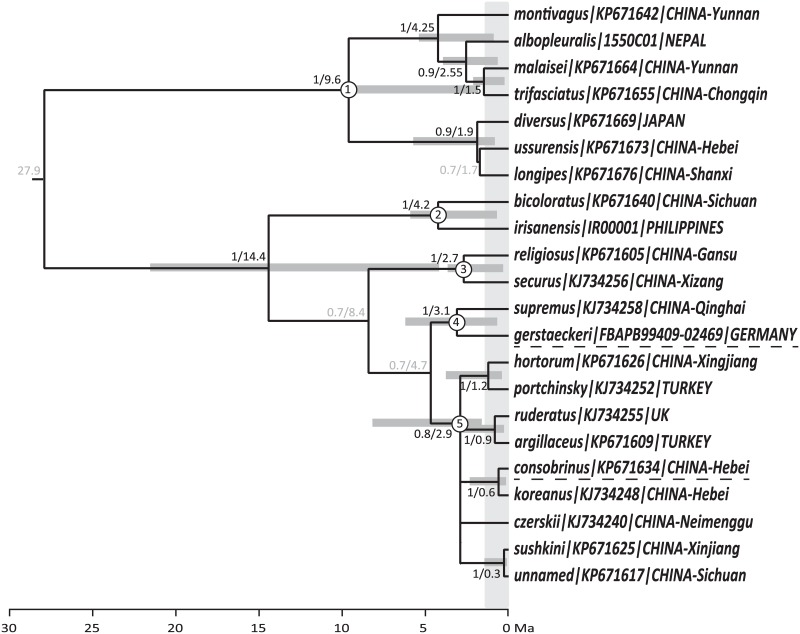
Dated estimate of phylogeny for species of the subgenus Megabombus.From Bayesian analysis of COI barcodes, using single samples selected to represent each of the species from Fig 2 and using the birth-death process for speciation on the tree. The tree is dated in Ma by setting the date for the divergence with the Mendacibombus outgroup to 34 Ma [33]. Values at each node: posterior probability / age in Ma. Nodes with support p≥0.8 show 95% confidence limits for the date estimate as grey bars; nodes with support p<0.8 have the values shown in grey; nodes with support p<0.66 are shown collapsed. The vertical gray line show the 1.3 Ma position to distinguish between the two time periods. The extreme food specialization species name with under dashed line.